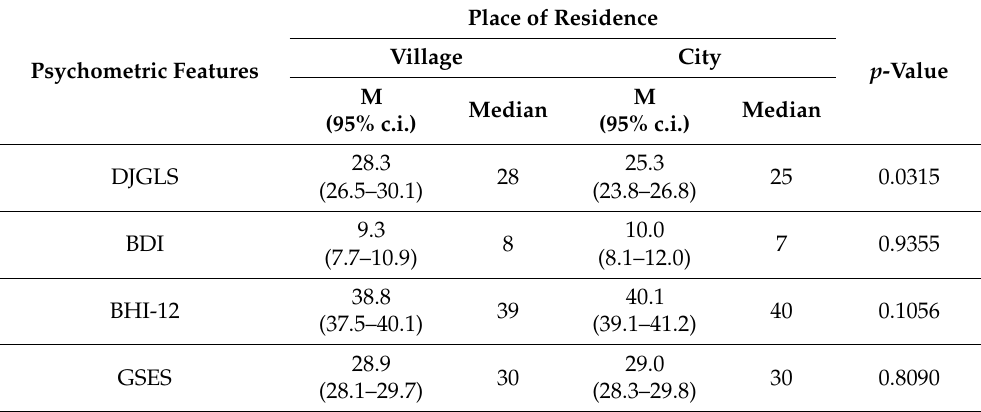
Table 5. Correlations between the applied psychometric scales and the place of residence. Psychometric